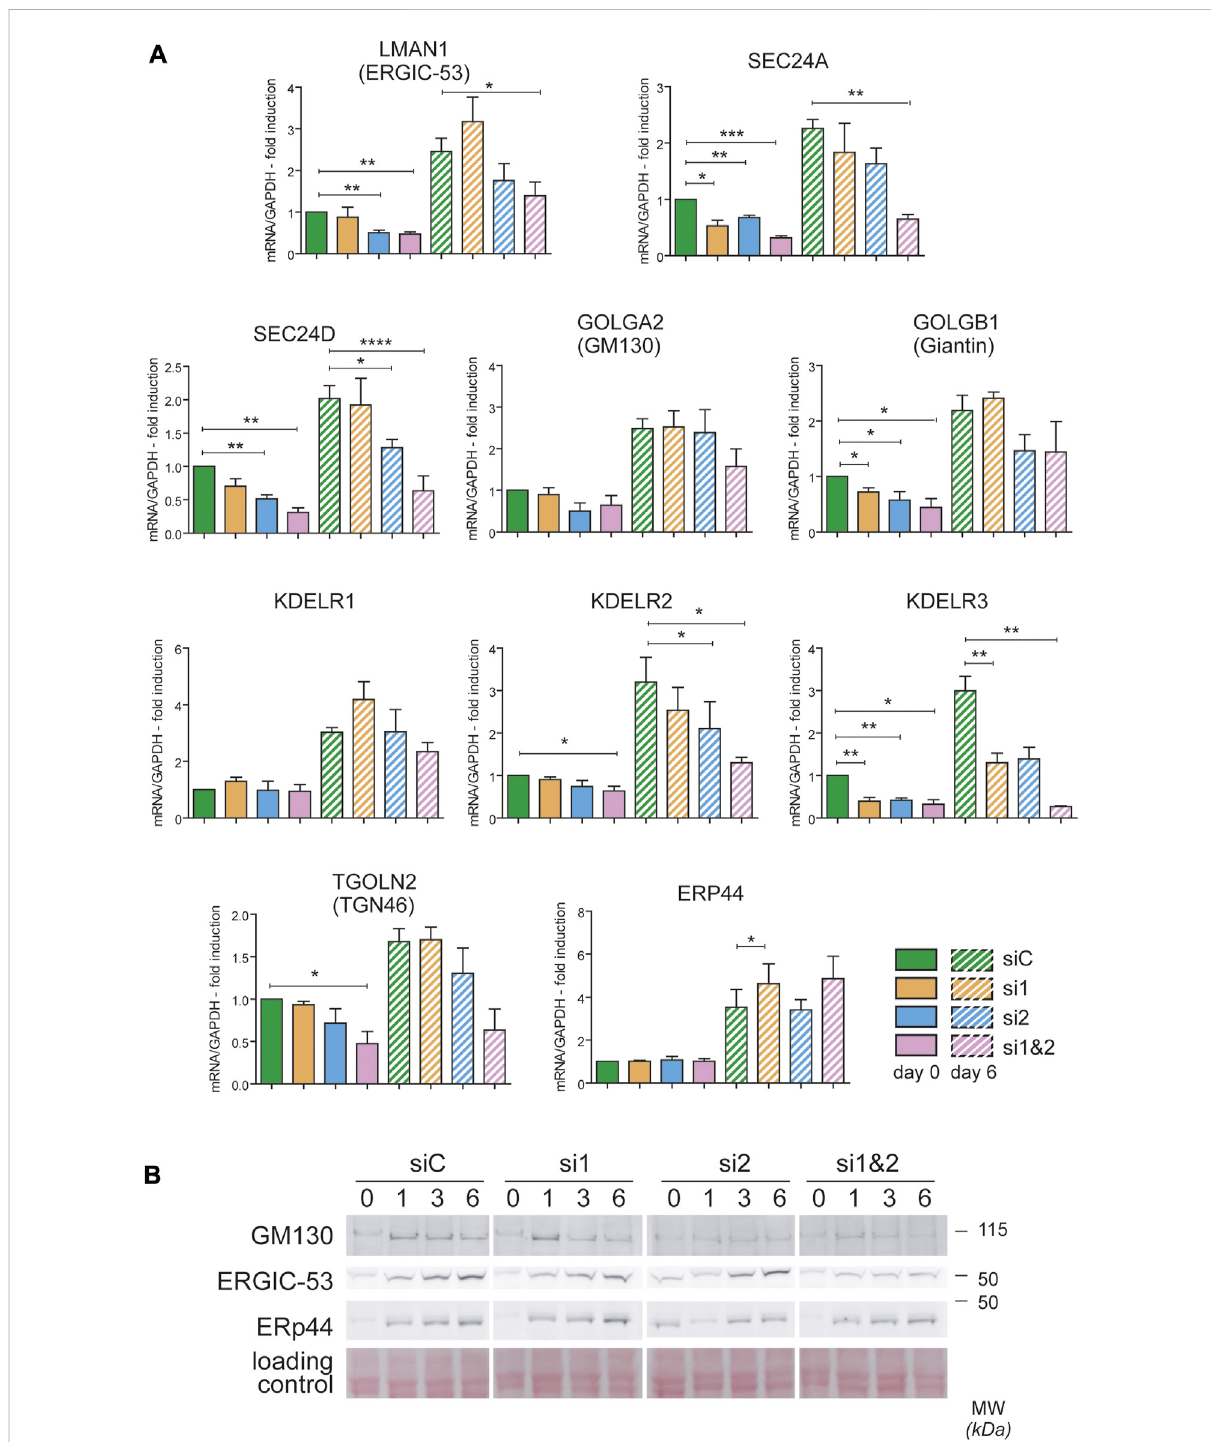
FIGURE 5 CREB3L1 and CREB3L2 drive the upregulation of many genes of the early secretory pathway during decidualization. T-HESC were treated with scramble duplexes (siC, green bars), with duplexes speci fi c for CREB3L1 (si1, orange), CREB3L2 (si2, light blue) or both (si1&2, pink). The day after treatment (day 0) cells were collected or treated with cAMP and progesterone and then collected at day 6 of decidualization. (A) mRNA for different genesencodingproteinsoftheearlysecretorypathwaywereanalyzedbyqPCRandexpressedasfoldinductiontoday0siCafternormalization on GAPDH. Solid bars represent values at day 0, striped bars values at day 6. Average of 3 – 4 independent experiments ± SEM. * p < 0.05; ** p < 0.01; *** p < 0.001;**** p < 0.0001, t -testvsday0siC.TheKDofCREB3L1and/or2affectstheexpressionofthemajorityofthegenesanalyzed,bothatday 0 and after 6 days of decidualization. (B) Total protein extracts were loaded on SDS PAGE under reducing conditions (40 µg of proteins/lane). The behaviorofGM130,ERGIC-53andERp44areshown.WhileERGIC-53andGM130sufferfromtheabsenceofCREB3L1and/or2,theproteinlevelsof ERp44 are unaffected. A part of the ponceau is shown as a loading